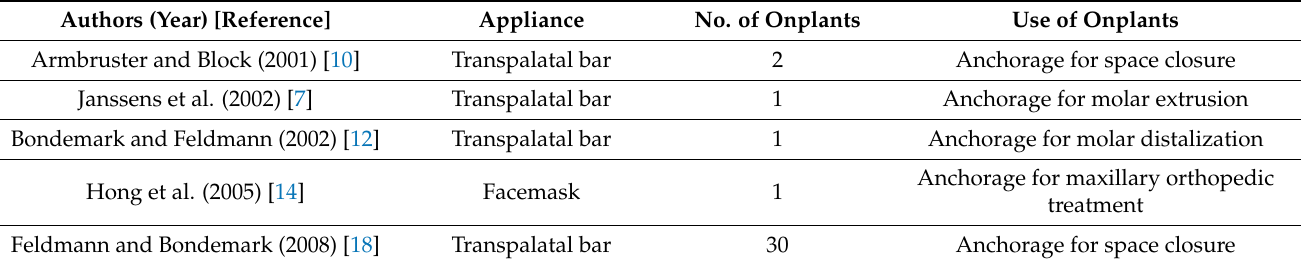
Table 3. Appliance used and treatment types performed with